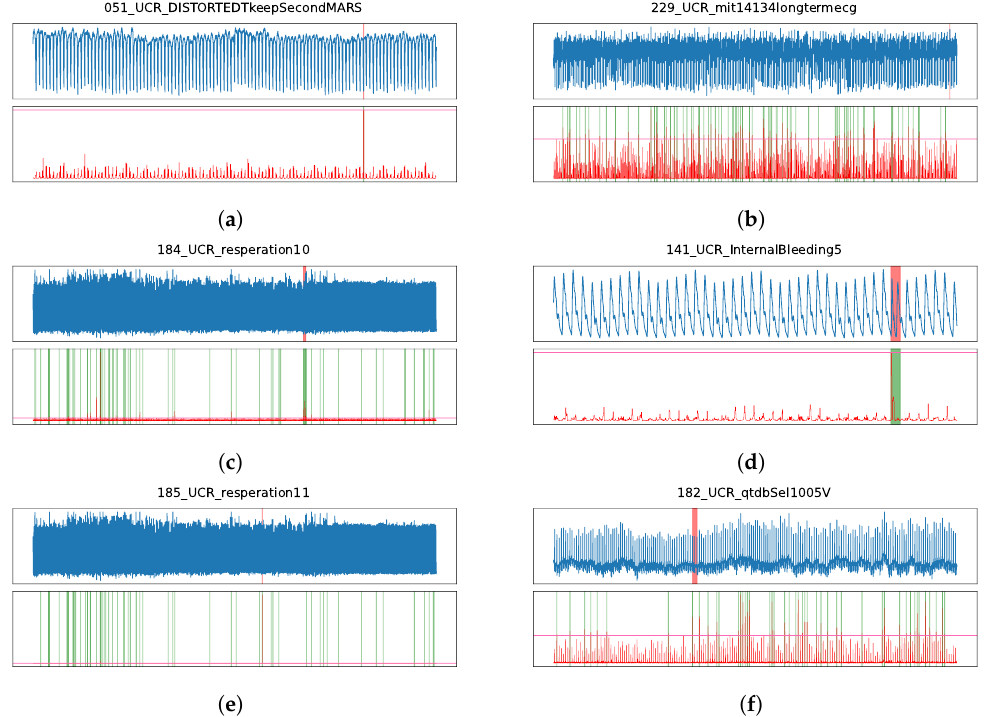
Figure 10. Interpretation of results shown on examples of the autoencoder model. The top figure represents the time series with the true anomaly marked in red, while the bottom figure shows the anomaly score, with the pink horizontal line being the determined threshold and the predicted anomalies highlighted in green. ( a ) High AUC ROC, F1- and UCR scores indicate correct detections without or with very few false positives. ( b ) High AUC ROC but low F1- and UCR score indicate an insufficient anomaly score and/or an insufficient threshold. ( c ) A high F1- but a low UCR score indicates the detection of the true anomaly but a false positive has a higher anomaly score. ( d ) Low AUC ROC but high F1- and UCR score indicate a correct detection of the labeled anomaly without or with few false positives but the detected subsequence is shorter than the true anomaly. ( e ) High UCR- but low F1 score indicates the correct detection of the true anomaly by the highest anomaly score but a bad threshold value leading to an increased number of false positives. ( f ) Low AUC ROC, F1- and UCR scores indicate an insufficient anomaly score not detecting the true